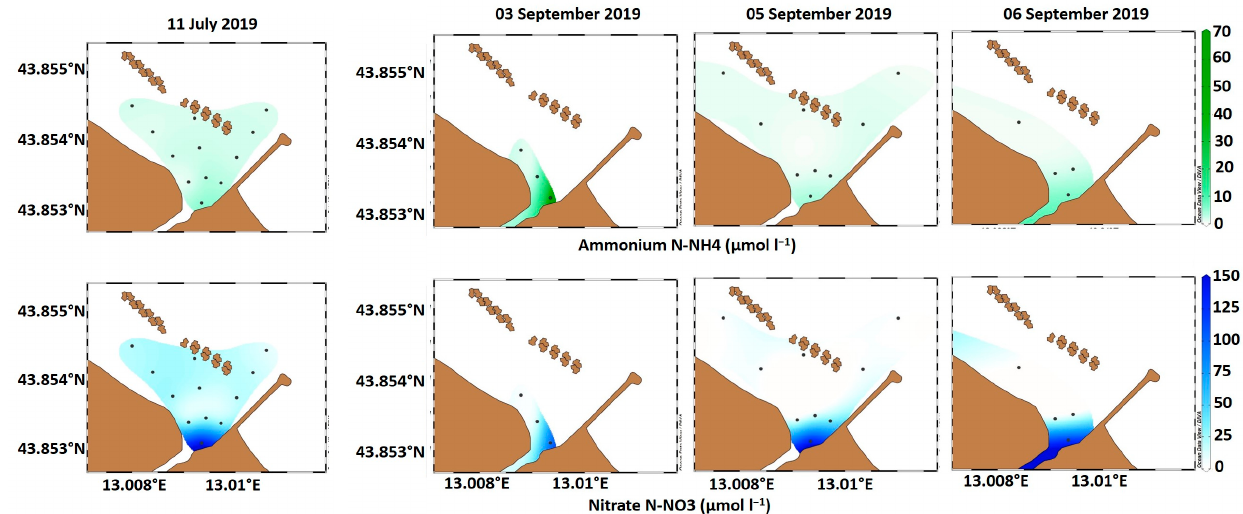
Figure 3. Ocean data view [15] maps showing the spatial distributions of nutrient concentration (NH 3 and NO 3 ) in seawater from sampling stations to offshore along the three transects in front of the Arzilla mouth during the 2019 rainy events (July and September 2019). The graphs show the relative concentration of ammonium (in green) and nitrates (in blue).